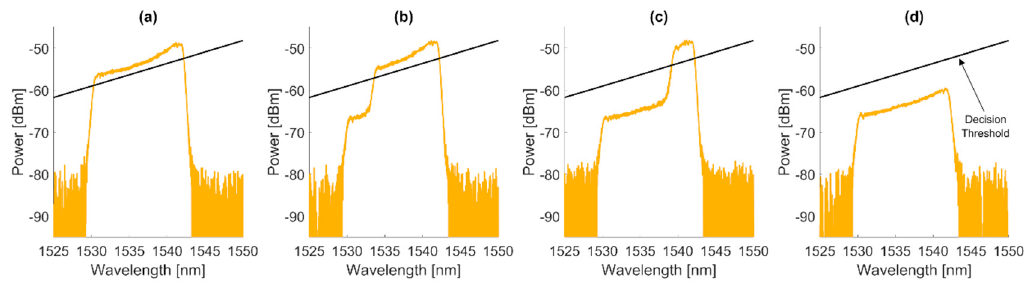
Figure 8. Sensor’s spectrum for various lengths. The first ( a ) and last ( d ) figure are the spectrum without any length reduction and after full abrasion, respectively. The second ( b ) and third ( c ) figure show the spectrum after the fourth (4 mm) and seventeenth (17 mm) cut, respectively. The decision threshold (black line) is the reference line from which the spectrum width was measured.